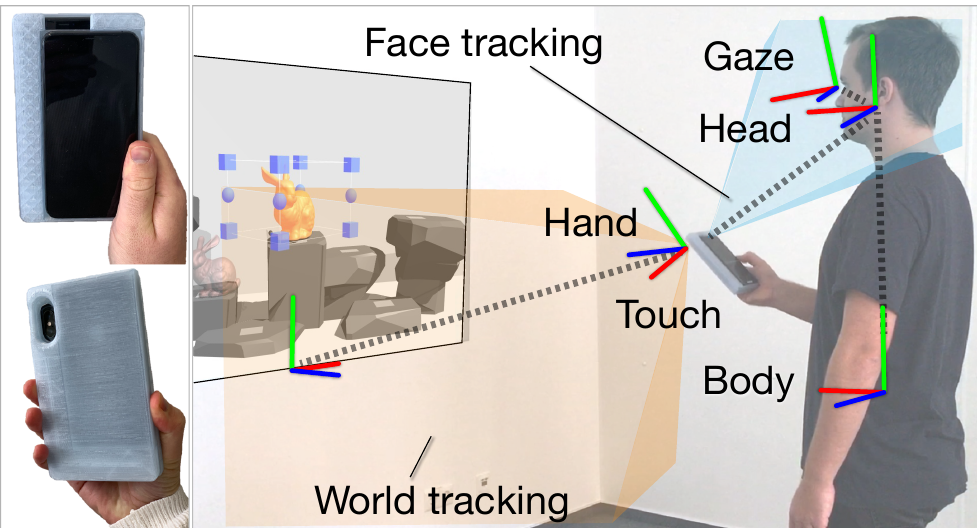
Figure 2. First prototype consisting of two smartphones used for the initial implementation of our tracking framework ( left ). TrackPhone tracking principle using simultaneously the front and rear camera of the smartphone for tracking touch and the absolute world-space pose of the user’s device (hand), body, head, and eye-gaze ( right